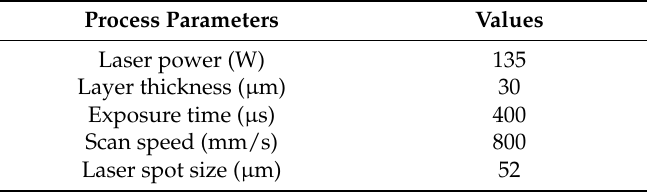
Table 1. Process parameters of preparing Ti6Al4V specimens.